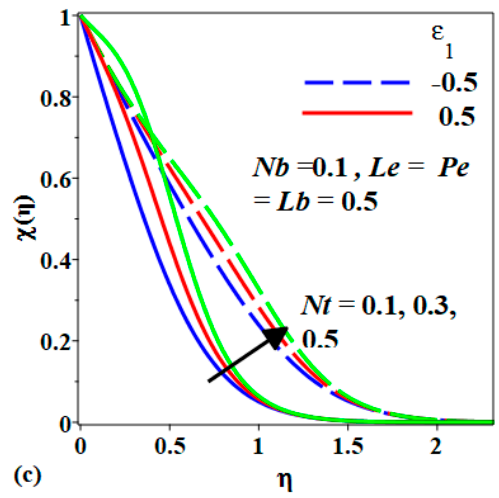
ε on ( a ) Figure 3. Variation of Nt and 1 Figure 3. Variation of Nt and ε 1 on ( a ) θ ( η ) ; ( b ) φ ( η ) and ( c ) χ ( η ) . Figure 3. Variation of Nt and